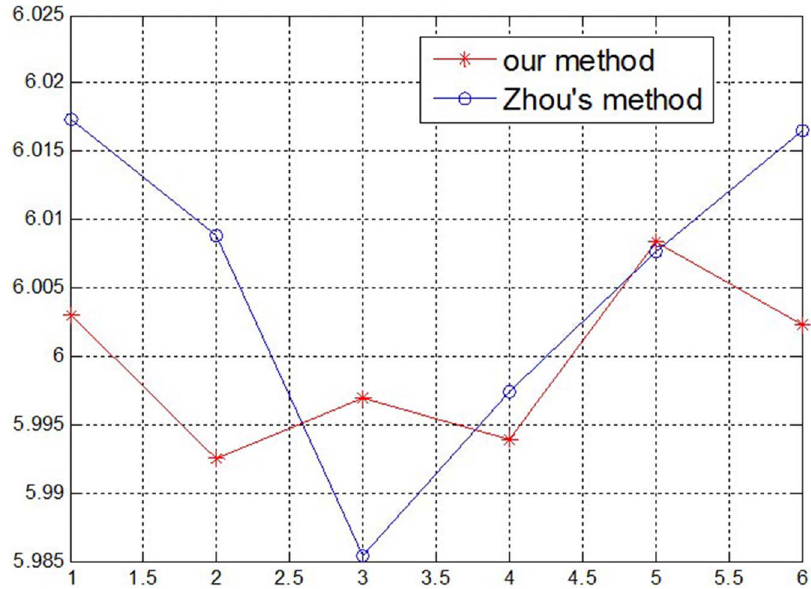
Figure 16. The measurement results of 6 mm Gauge block.